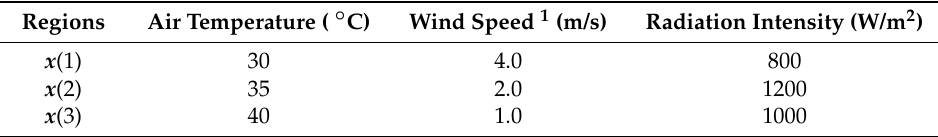
Table 3. Parameters of meteorological